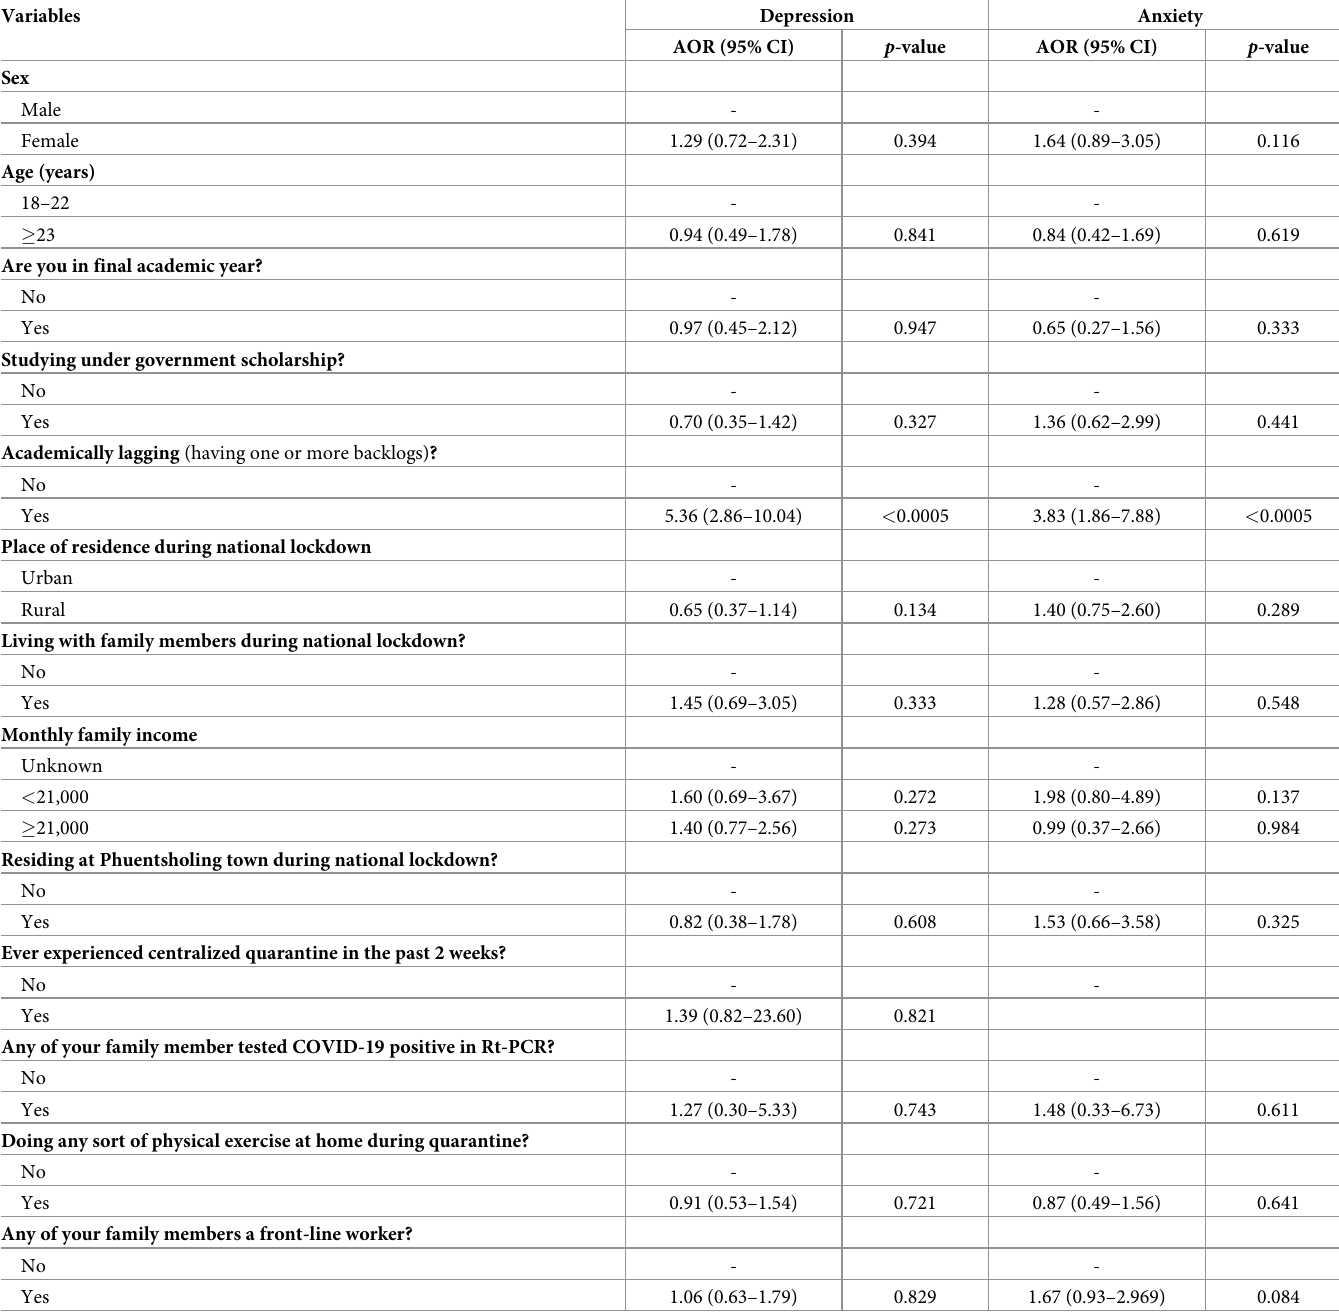
Table 3. Factors associated with self-reported depression and anxiety among students studying at CST during COVID-19 pandemic.